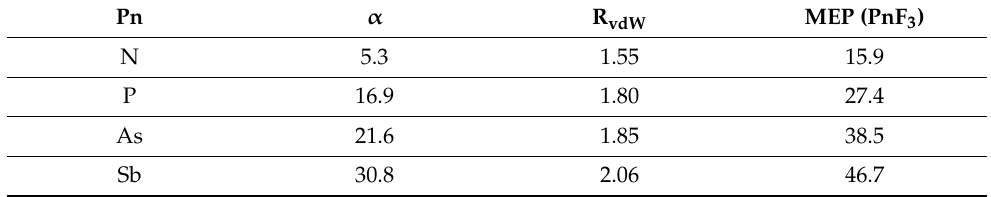
Table 1. Atomic polarizabilities ( α , a.u.) of pnictogen (Pn) elements, van der Waals radii (R vdW , Å) and σ -hole MEP value (MEP, kcal/mol) of their trifluoride derivatives. Data extracted from ref. [63].